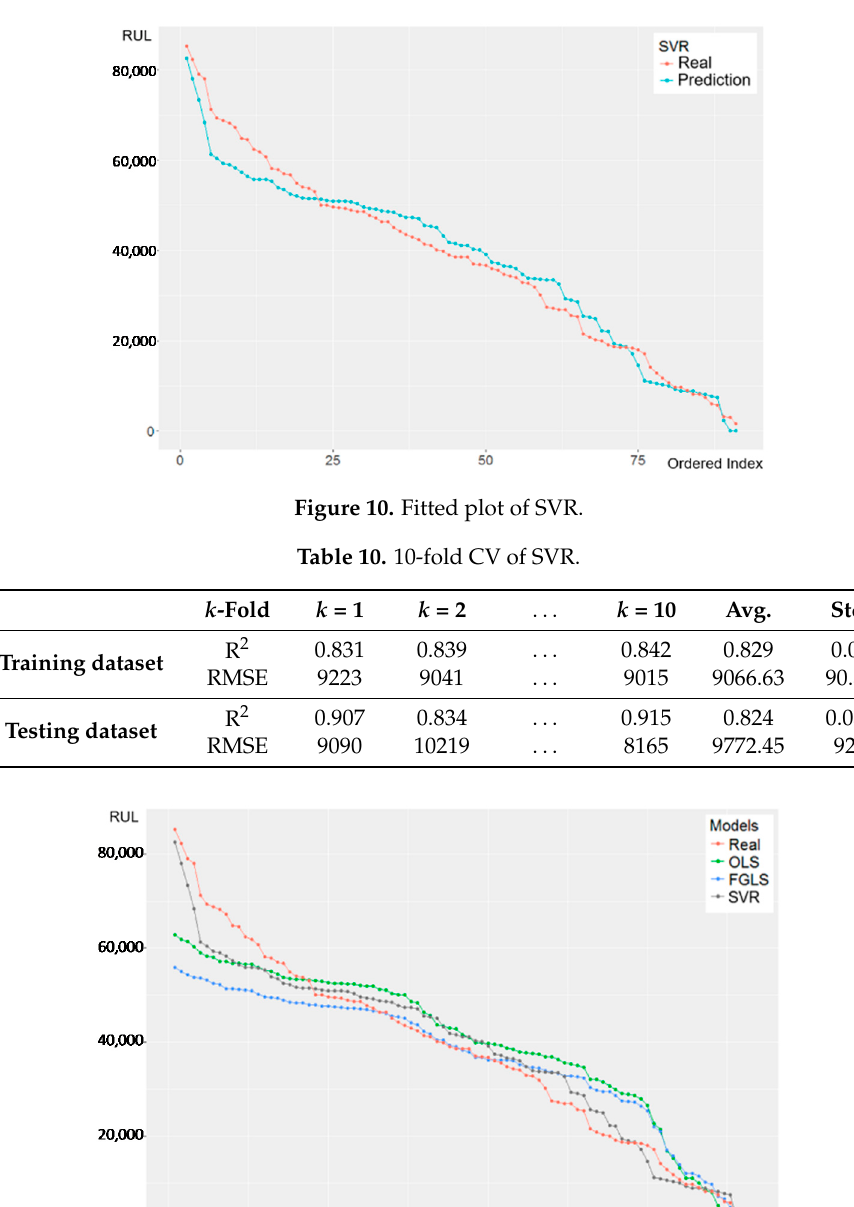
Table 10. 10-fold CV of SVR. k -fold